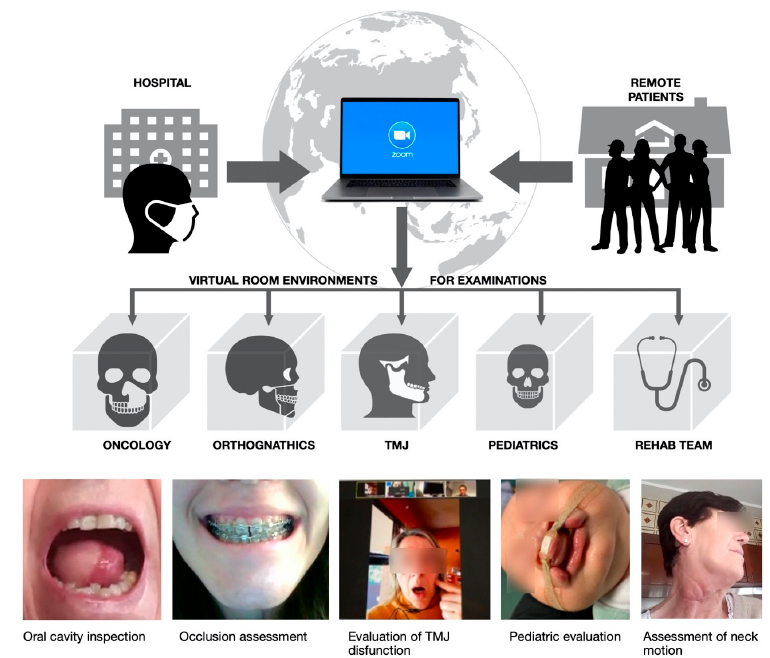
Figure 2. Organization of consultation rooms into VREs and clinical examples.